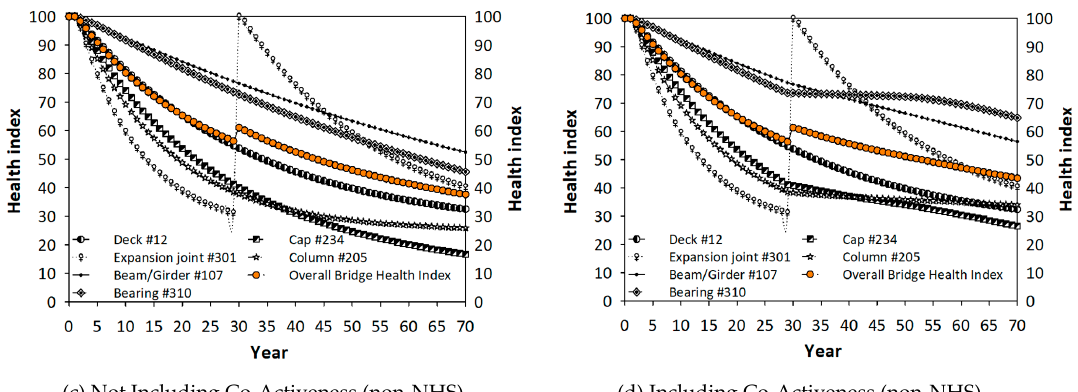
Figure 18. The effect of an expansion joint replacement not including and including the co-active mechanism: ( a ) and ( b ) in NHS bridges, ( c ) and ( d ) in non-NHS bridges in New York.